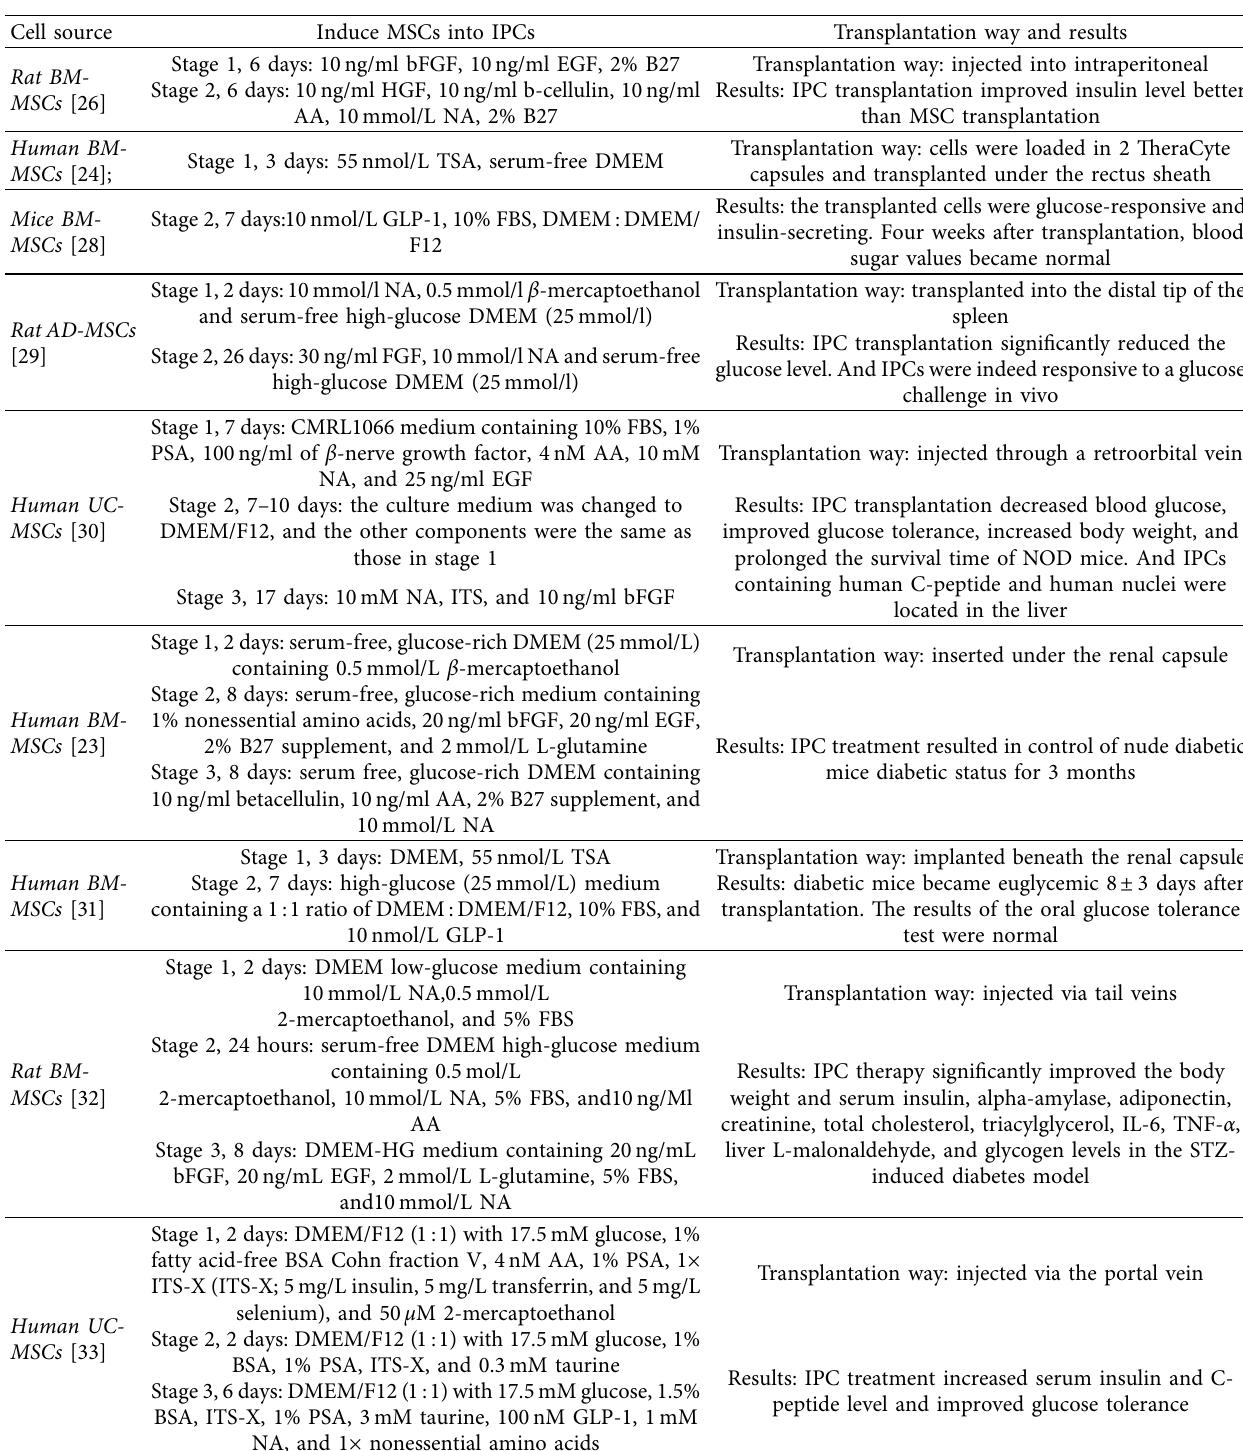
Table 1: Protocols that induce MSCs into IPCs.